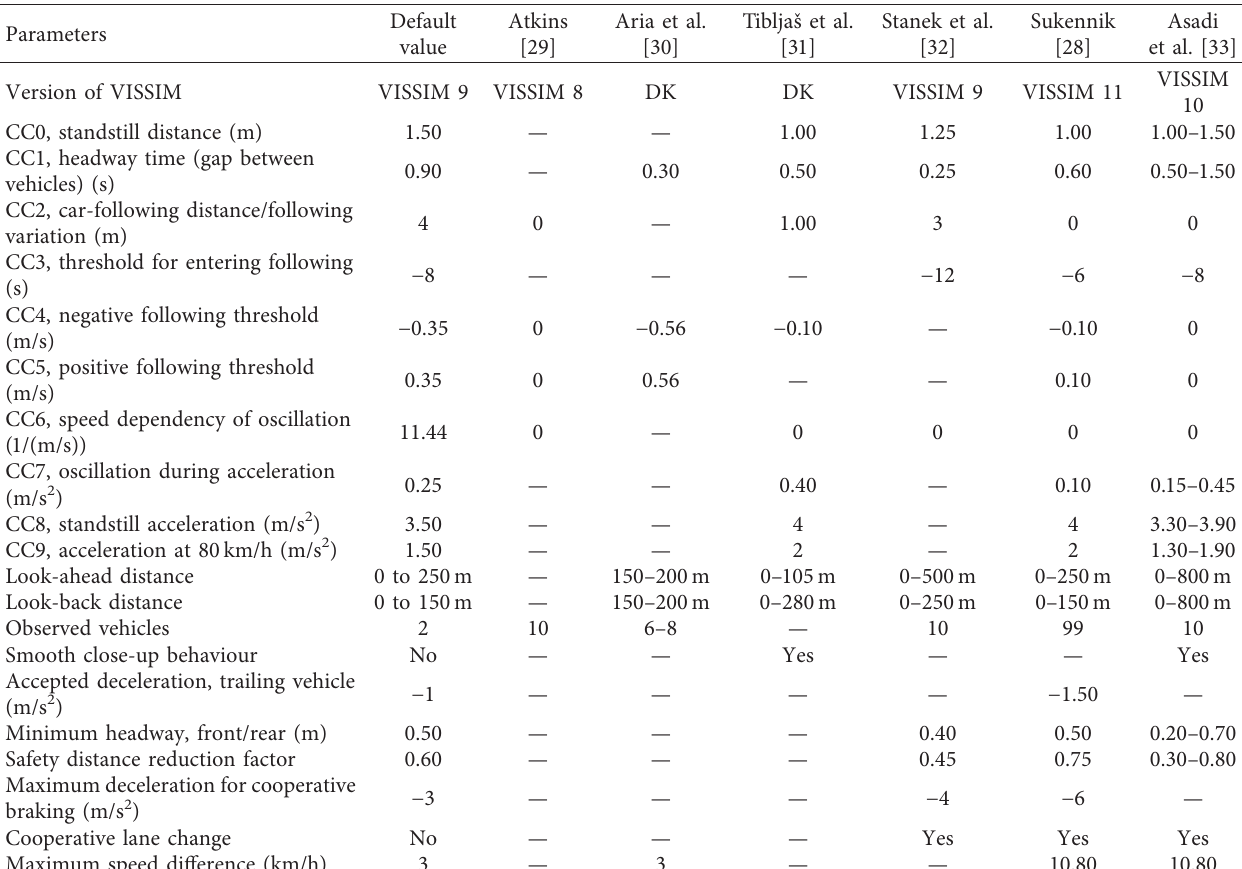
Table 1: Existing studies on CAV simulation by the internal model.